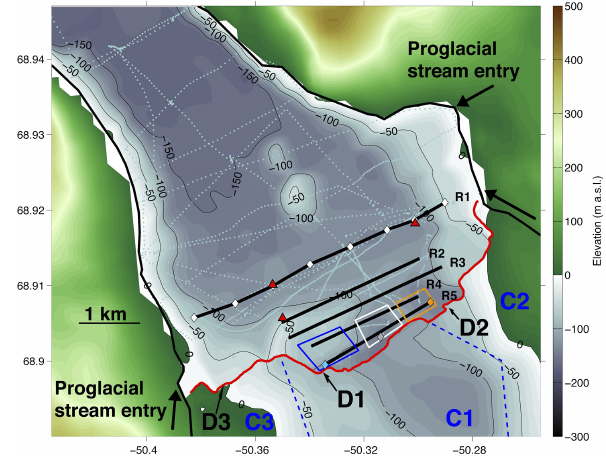
Figure 3. July 2012 Survey of Sarqardleq Fjord. Sarqardleq Fjord bathymetry (10m colored contours below sea level within fjord) and Morlighem et al. (2014) bedrock elevation map (10m colored contours above and below sea level outside of fjord) are shown. The Saqqarliup sermia front position and coastline from a 19 June 2012 Landsat image are mapped in red and black lines, respectively. Depth measurements collected during July 2012 field operations used to create the Sarqardleq Fjord bathymetry are plotted as grey dots over the contoured bathymetry. REMUS transects R1–R5 are shown in black, with LBL transponders mapped with red trian- gles. Subglacial subcatchments C1, C2, and C3 dividing lines from MBM2014 analysis are mapped in dashed blue line, with the lo- cation of D1, D2, and D3 subglacial discharge channels along the submerged terminus shown with thin black arrows. CTD casts are shown with diamonds: white diamonds are CTD casts along R1 used in REMUS cross-calibration, and the blue, gold, and grey di- amonds are CTD casts 1, 2, and 3 that were taken along R5 within GMW1, GMW2, and the region between GMW1 and GMW2 (out- lined in blue, gold, and white, respectively). Three proglacial stream entries to Sarqardleq Fjord are shown along the northeast and south- west fjord coastlines with thick black